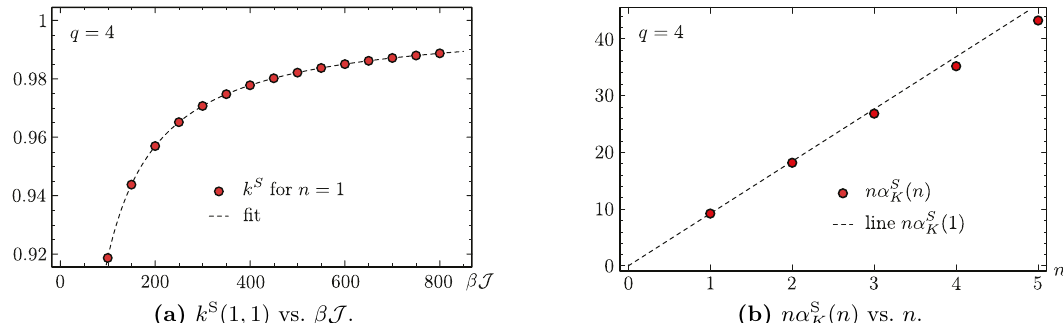
( n ) almost does not K